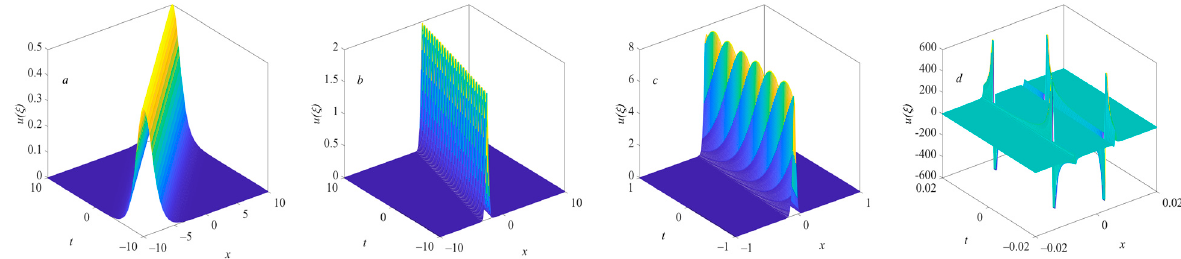
Figure 1. Evolution of solitary waves with n in u 1 n when k = 1: ( a ) n = 1, ( b ) n = 2, ( c ) n = 3, and ( d ) n = 4.